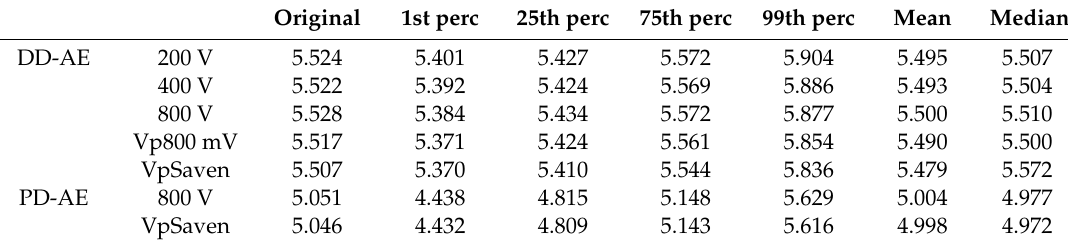
Table 3. DD-AE and PD-AE values of the “original” and simulated datasets.